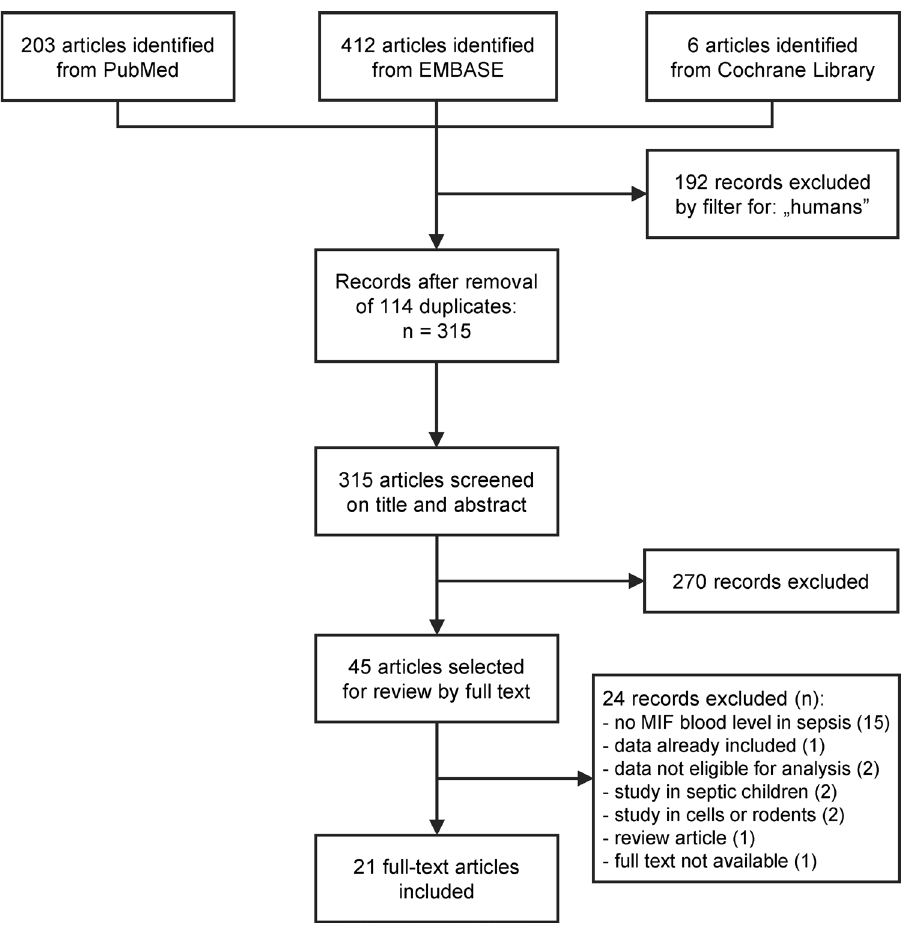
Figure 1. Flowchart of study selection and